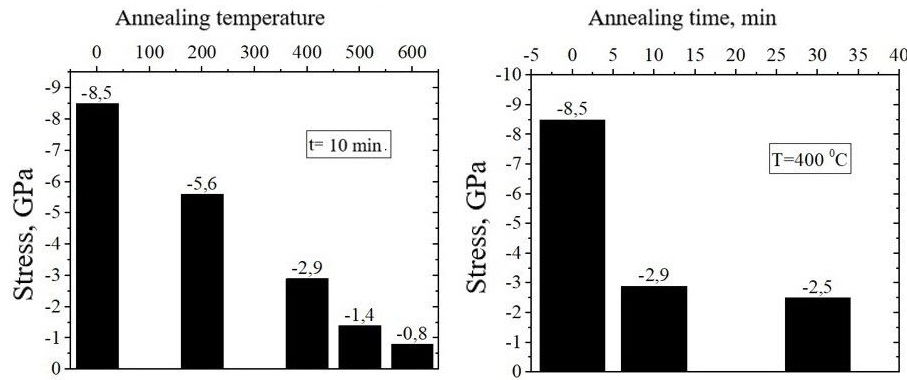
Figure 2: Stress reductions in 200 nm thick ta-C deposited films vs. annealing temperature (left) and time